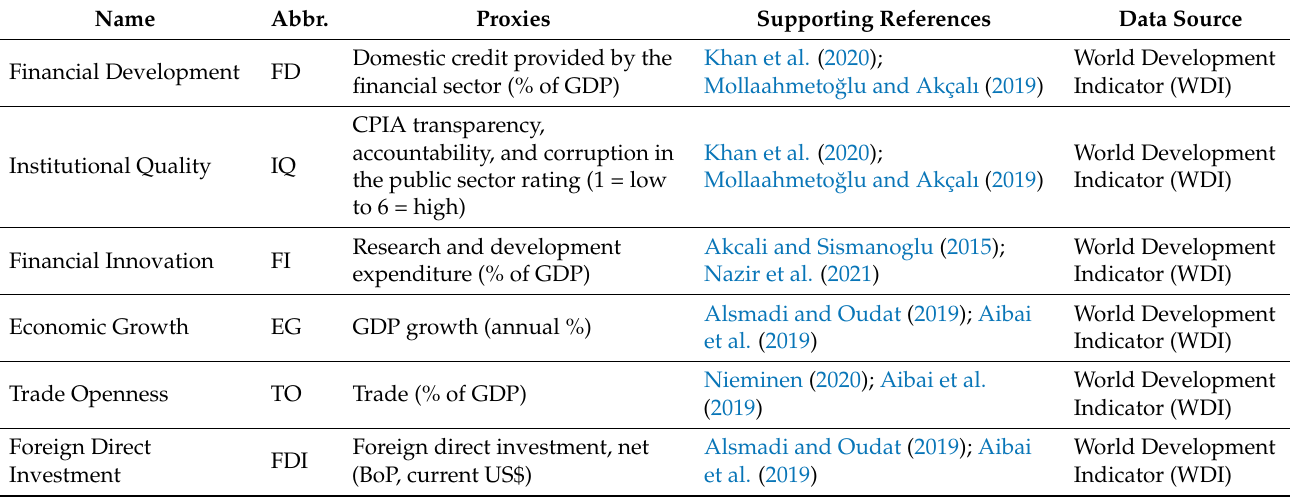
Table 1. Variable